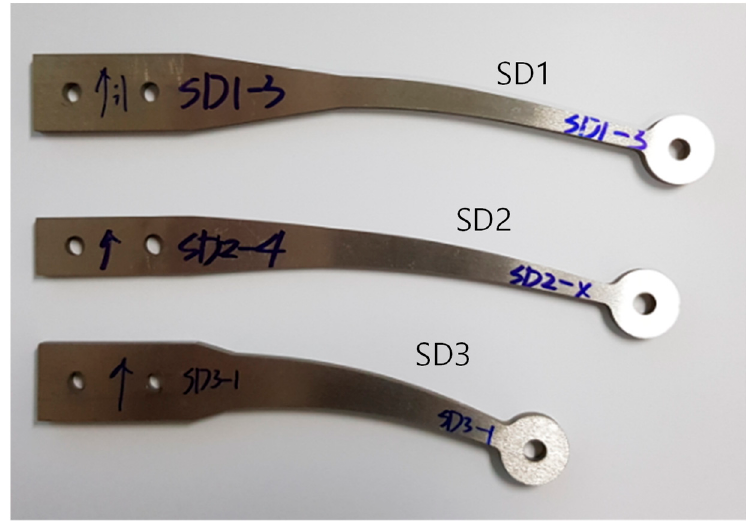
Figure 17. Deformed shapes of steel dampers after the maximum displacement loads.